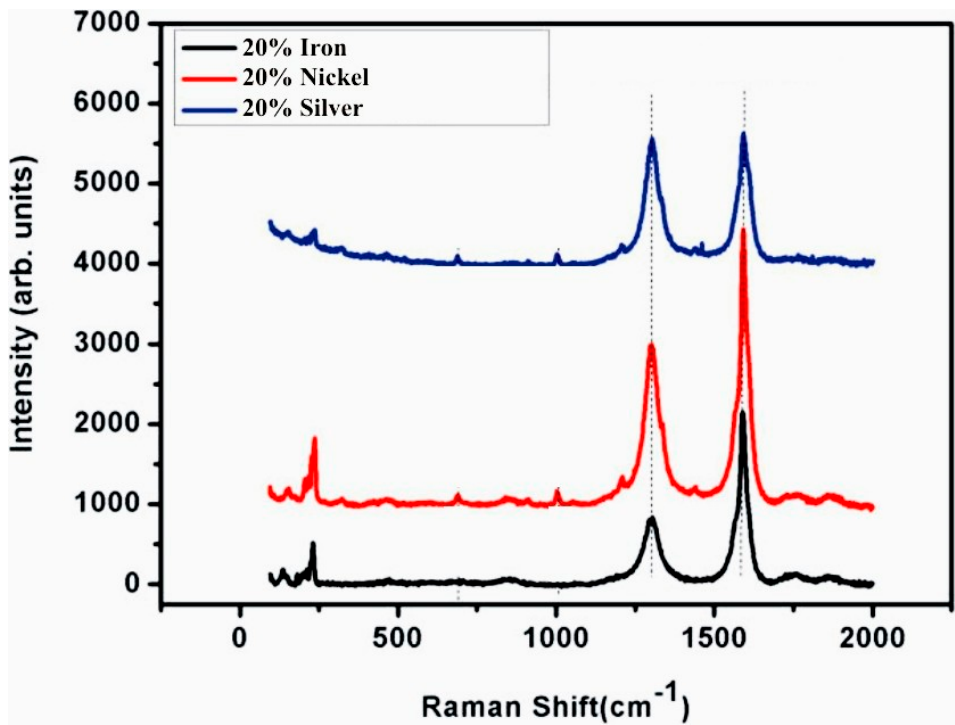
Figure 4. Raman spectra of synthesized SWCNT under iron, nickel, and silver catalysts.